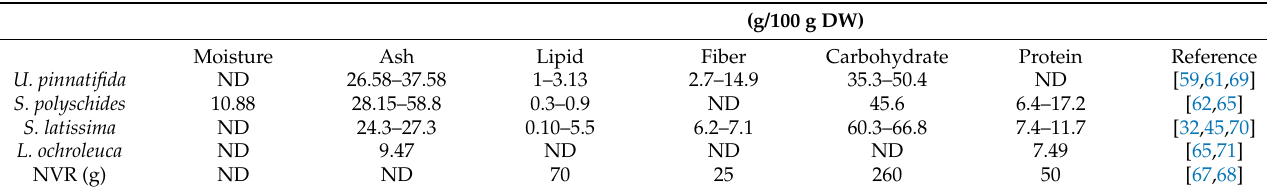
Table 9. Nutritional characterization of the dried biomass of U . pinnatifida , S . latissima , L . ochroleuca , and S . polyschides according to the literature. ND—not